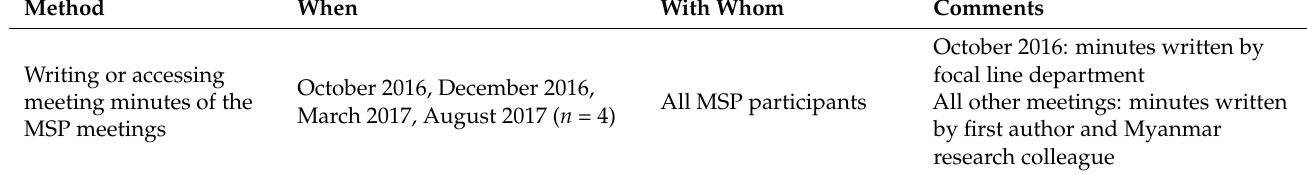
Table 3. Details of data collection (MSP: multi-stakeholder platform, OMM: OneMap